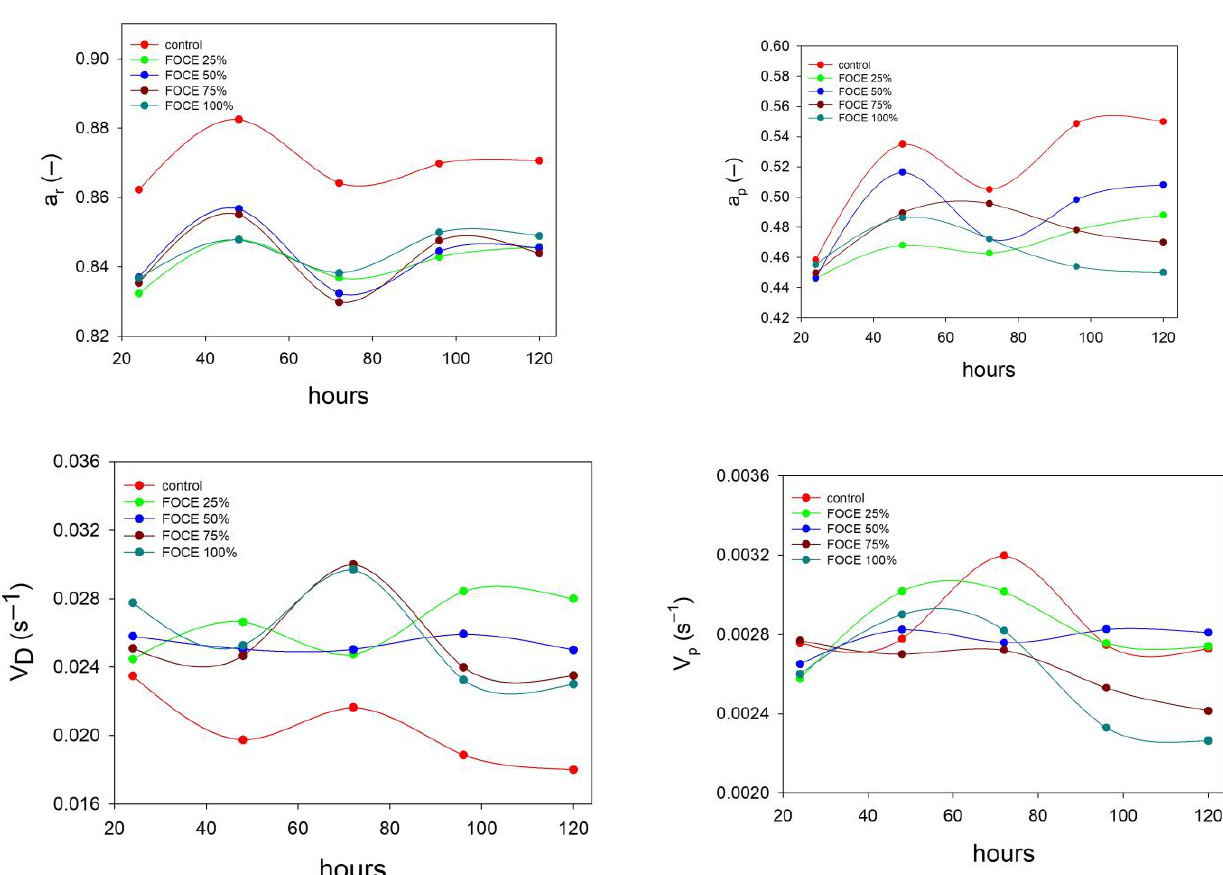
Figure 3. The results of measurements of the water activity of FOCE-containing GFBs.